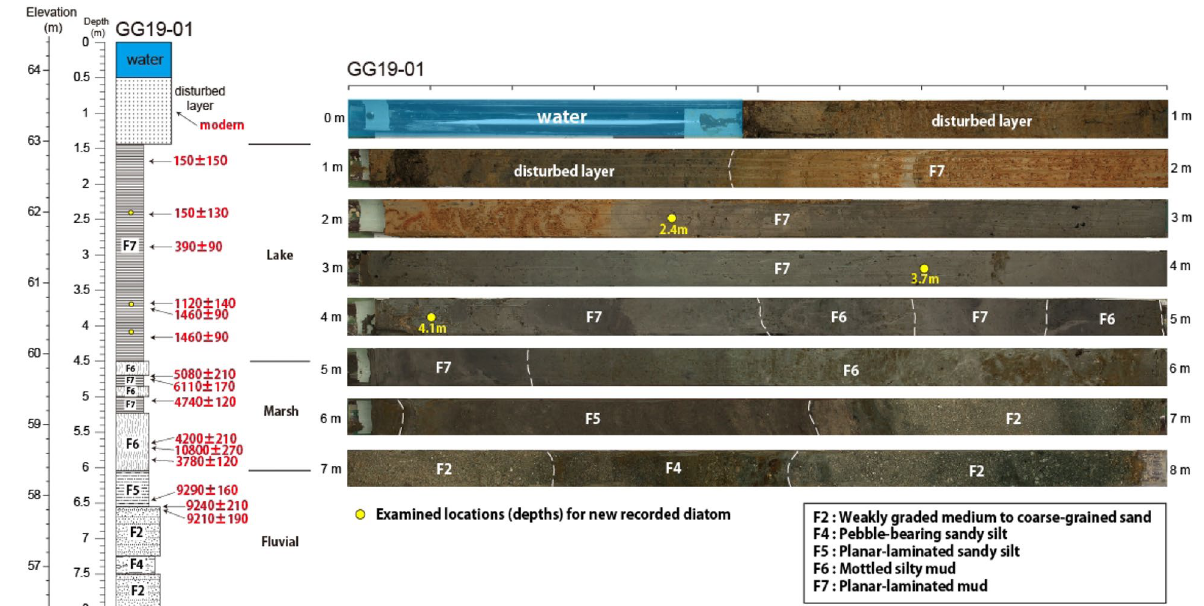
Fig. 2 Stratigraphic section, age dating, and photographs of the sediment core at sampling site